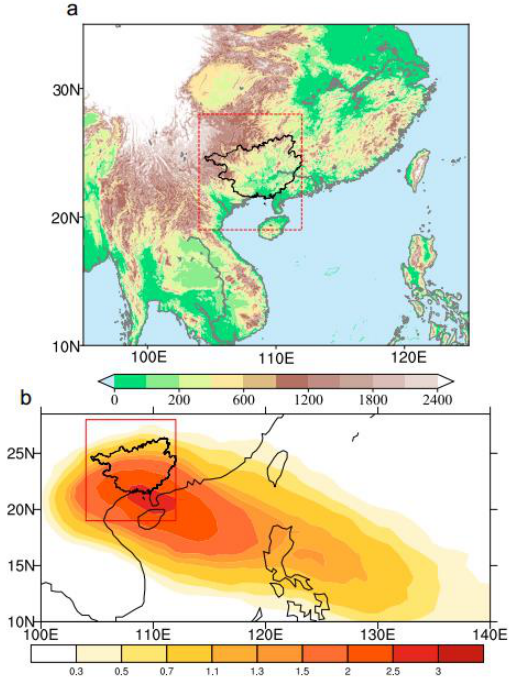
Figure 1. The maps in ( a ) denote the altitude (shading, units: m) over South Asia. The black line represents Guangxi. The domain of TC affecting Guangxi (19 ◦ N–28 ◦ N, 104 ◦ E–112 ◦ E) is outlined by the red box. ( b ) Spatial patterns of the climatological mean track of tropical cyclones affecting Guangxi (shading, year − 1 ) with a 1 ◦ × 1 ◦ resolution during boreal summer in 1979–2019. The Tibetan Plateau (TP) is the largest and highest plateau of the world and is also known as the world’s third pole [18,19]. The TP is located in the subtropical Eurasian continent and to the northwest of Guangxi. Compared to the extremely steep Himalayas, the elevation of TP gradually decreases along the Hengduan Mountains toward western China and Indochina Peninsula. Correspondingly, the elevation of Guangxi gradually decreases from the northwest to the southern coastal areas (Figure 1a). With respect to climate states, the snowpack in the eastern TP almost melts away in summer, while the western TP (e.g., some high elevation areas) is covered with year-round snow [20,21]. Thus, the summertime atmospheric heat source is dominated by latent heat over the eastern TP and is dominated by sensible heat over the western TP [22,23]. In addition, the atmospheric heat source mainly comprises interannual variations of latent heating [24]. Latent heating (rainfall) in summer over eastern TP has significant impacts on the surrounding weather and climate [25–28]. Jiang et al. [26] showed that latent heating over the southeastern TP excites descending motion over the northern Indian subcontinent. The study also